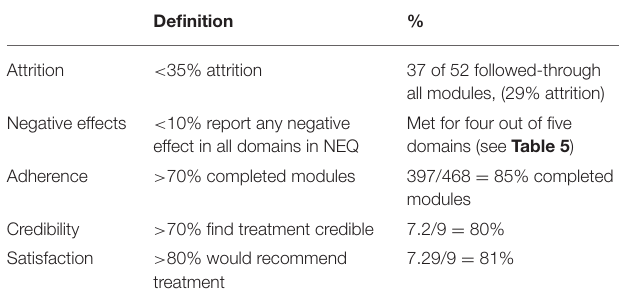
TABLE 2 | Demographic description of the participants.